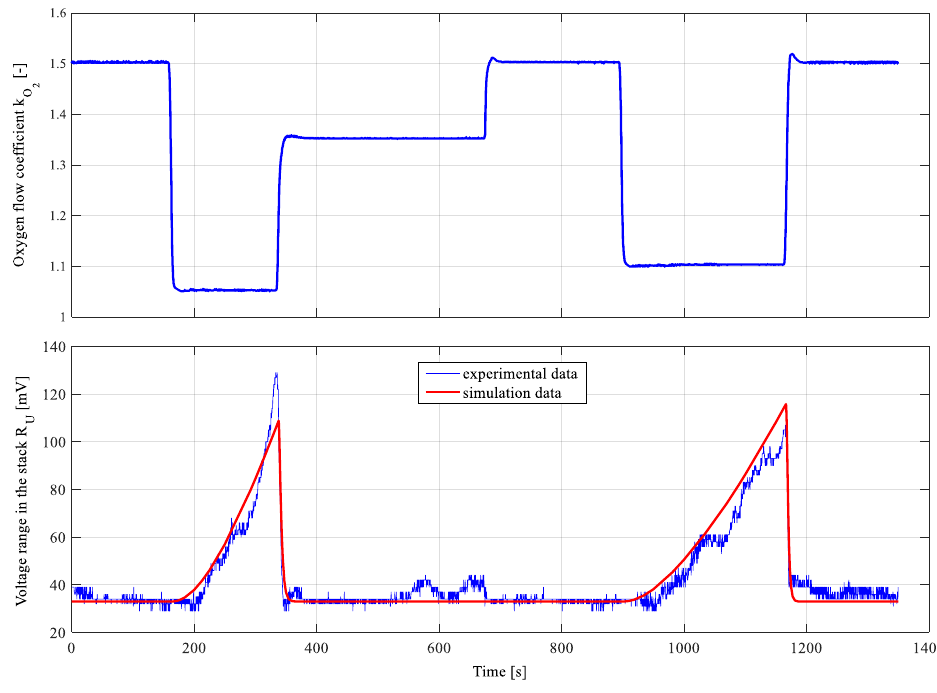
Figure 7. Model experimental verification for a 50 A load current.